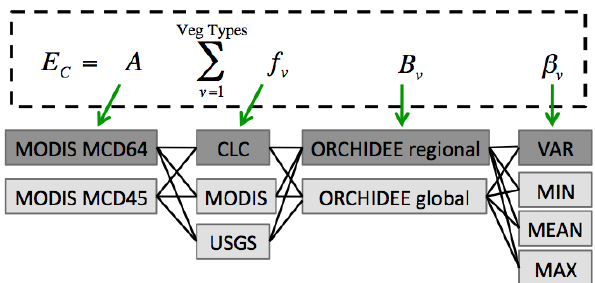
Fig. 10. Schematic representation of the 48 configurations used for the ensemble calculation of carbon emissions. The 4 scenarios for the fraction of biomass available for burning β are: minimum efficiency (MIN), maximum (MAX), average (MEAN) and varying depending on moisture stress (VAR). The dark gray boxes correspond to the default options for each of the parameters.